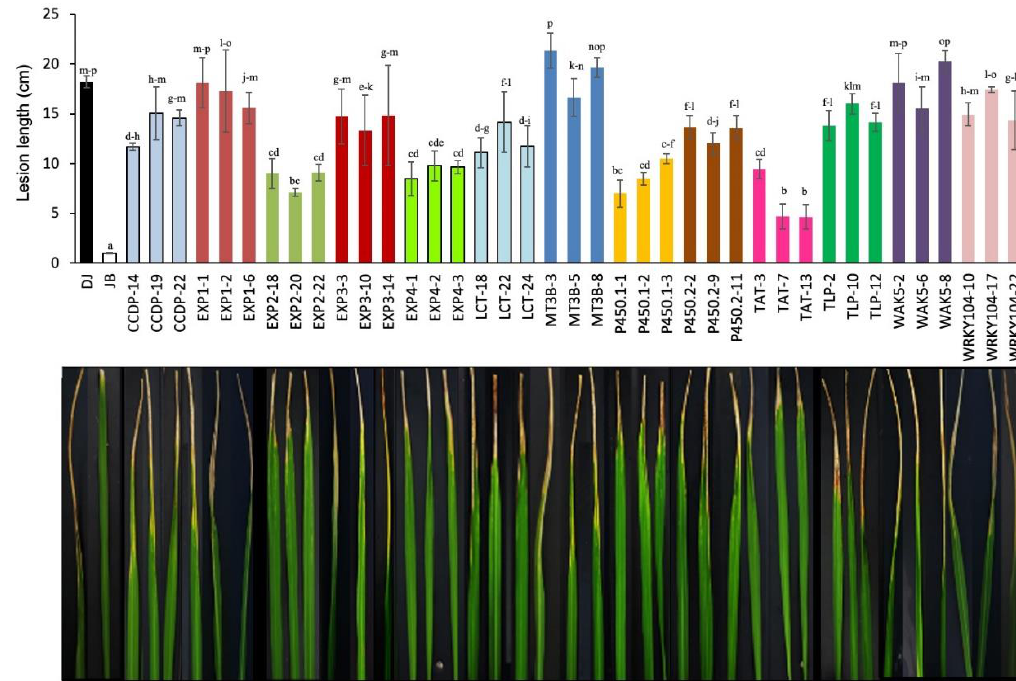
Figure 8. Attenuation of X. oryzae pv. oryzae race K2 virulence on rice overexpression transgenic plants. Lesion length of bacterial blight measured in cm at 16 dpi. Genes were coded, as mentioned above. Data presented are means ± SD from 3 replicates and different letters above the bars indicate significant difference at p < 0.05 level.